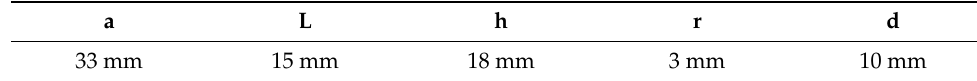
Figure 2. Four-pole quad-mode resonator with proposed dimensions. Table 1. Dimensional parameters of four-pole quad-mode